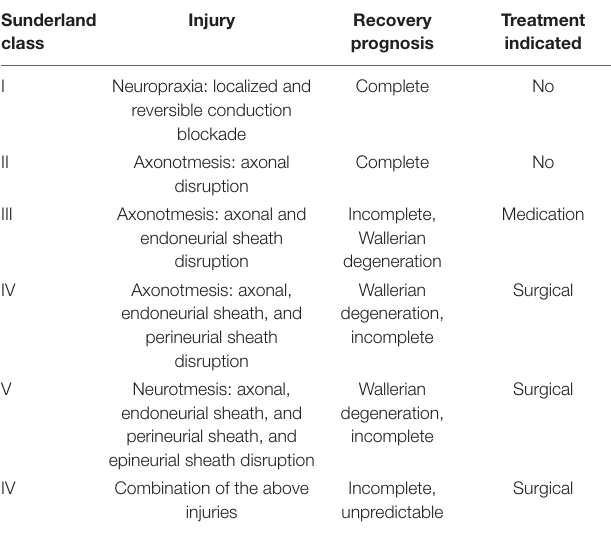
TABLE 1 | Seddon-Sunderland classification of nerve